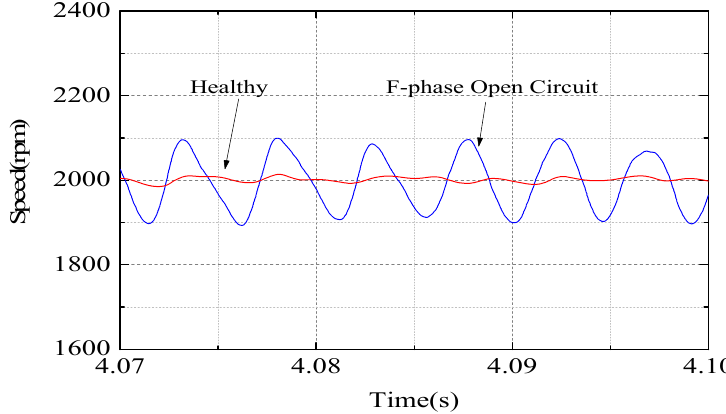
Figure 7. Motor speed in healthy operation and open circuit operation.